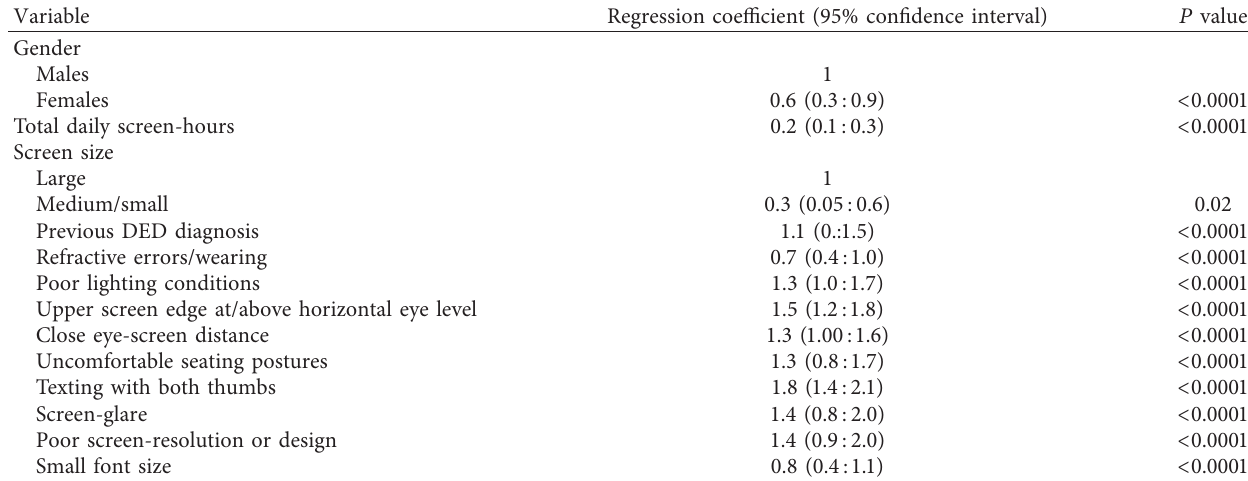
Table 8: Final multivariate linear regression analysis of factors affecting the total number of